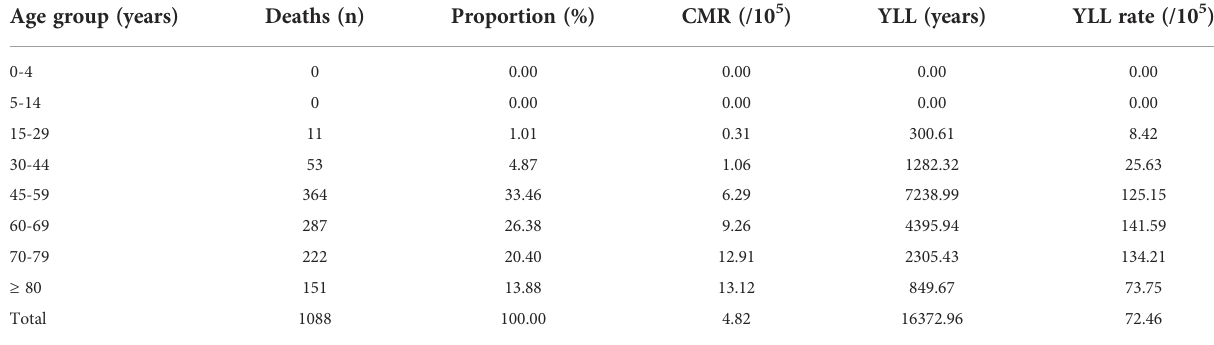
TABLE 2 Number of deaths, CMR, YLL, and YLL rate by age